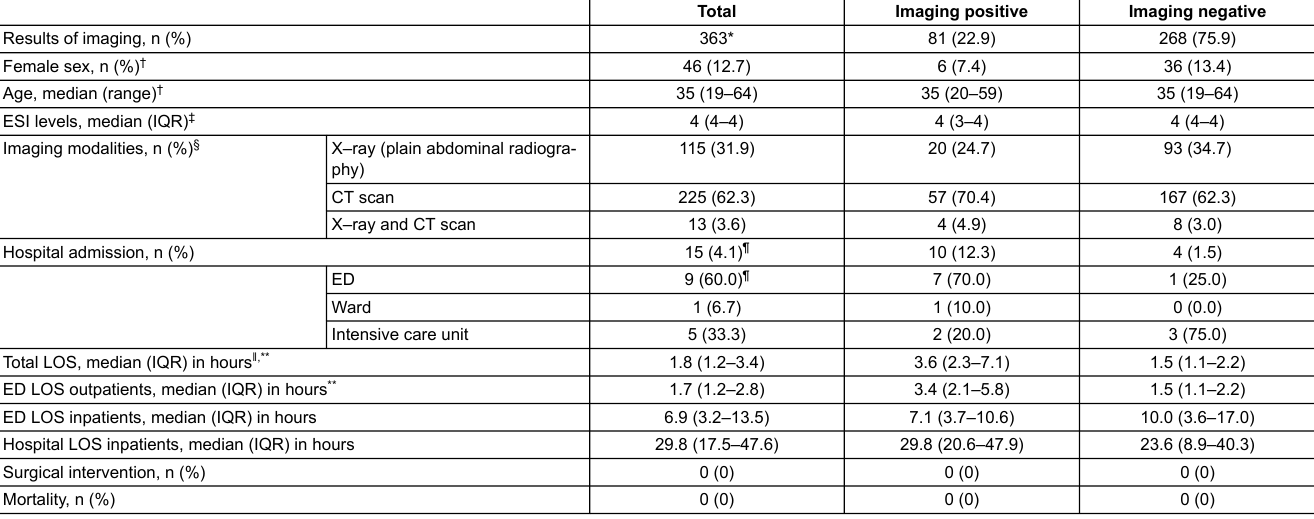
Table 1: Baseline characteristics. Results of imaging, n